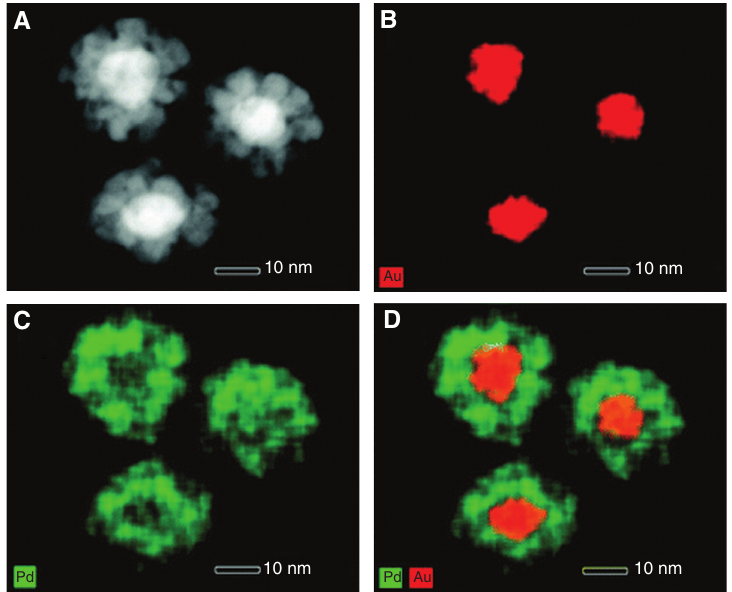
Figure 4 (A) HAADF-STEM image of nanoflowers consisting of a Au core and Pd petals. (B–D) Elemental maps obtained with EDX spectros- copy showing the distribution of Au (B) and Pd (C) in the nanoflowers, and an overlain image (D). From [50] with